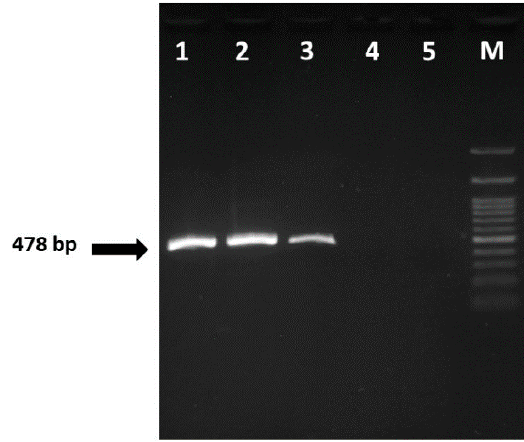
Figure 5. Detection of CEV DNA products (478 bp) by nested-PCR. Lane 1–3: gill samples of infected koi, lane 4: sample of healthy koi, lane 5: negative control with sterile water and lane M: 100 bp.